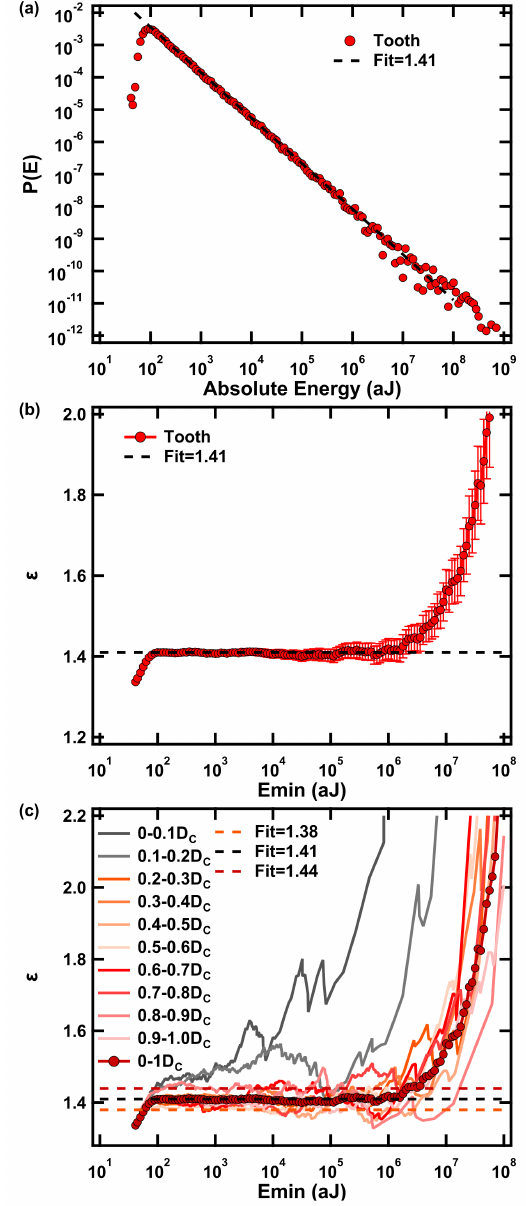
Figure 10. ( a ) The distribution of AE energy (double logarithmic scales) was fitted by P(E)~E − ε with ε = 1.4. ( b ) Maximum likelihood estimates the plateaus indicates the estimation for the energy exponent. The dashed black line indicates the slope of the PDF. ( c ) Maximum likelihood estimate for the energy distribution exponent at different strain levels. Reproduced with permission from [78]. Elsevier,